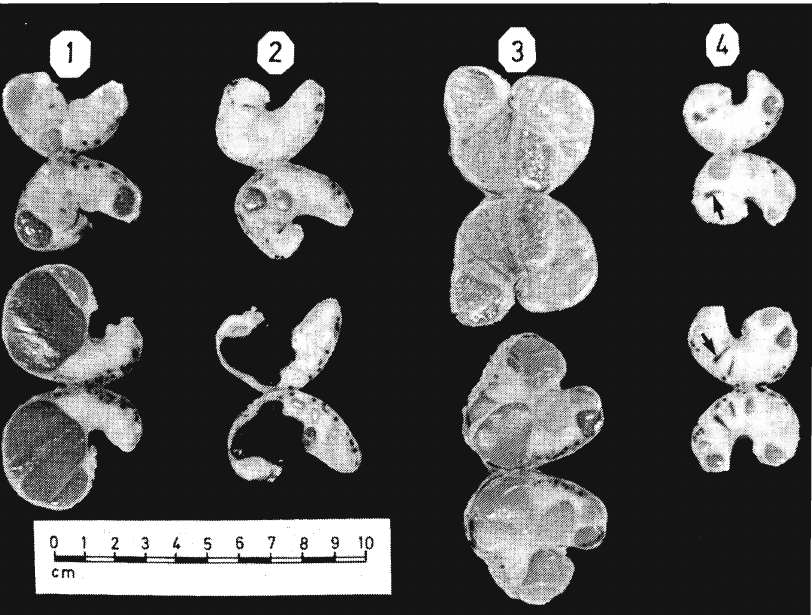
Fig. 7. Four pairs of Burchell's zebra ovaries cut from their free to attached b.orders and opened out to illustrate their internal appearance at four phases of the oestrous cycle. (I) Pro-oestrus - one follicle in the lower ovary has increased in size, while the upper ovary contains two corpora lutea from previous oestrous cycles; (2) Metoestrus - note the large corpus haemorrhagicum and the absence of large and medium-sized follicles; (3) Dioestrus - the corpus luteum has started to regress and follicular development is apparent. This is probably a late dioestrus specimen and most of the ovarian stroma is taken up with follicles of various sizes; (4) Anoestrus - the typical anoestrus ovary assumes a cashew nut shape and lacks medium-sized and large follicles. Dark brown corpora lutea in the final stages of regression (see arrows) are frequently present while stroma is very obvious. Notice that in all specimens ovulation has taken place via the ovarian